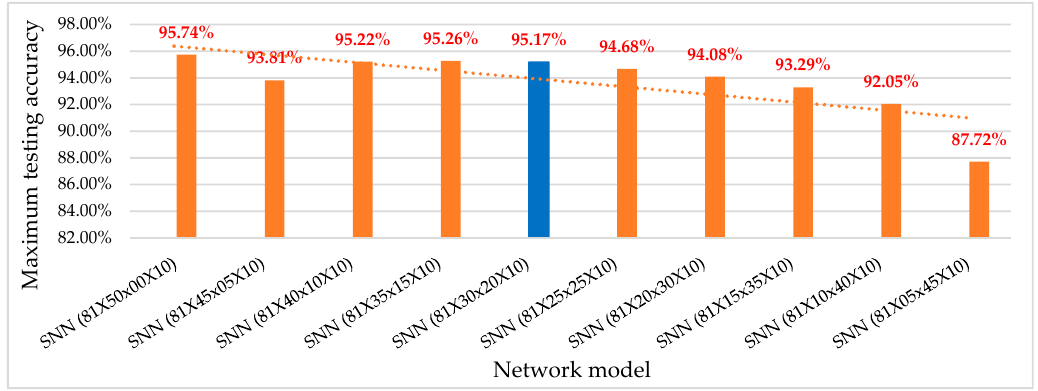
Figure 6. Maximum testing accuracy of SNNs with two hidden layers using various structures.